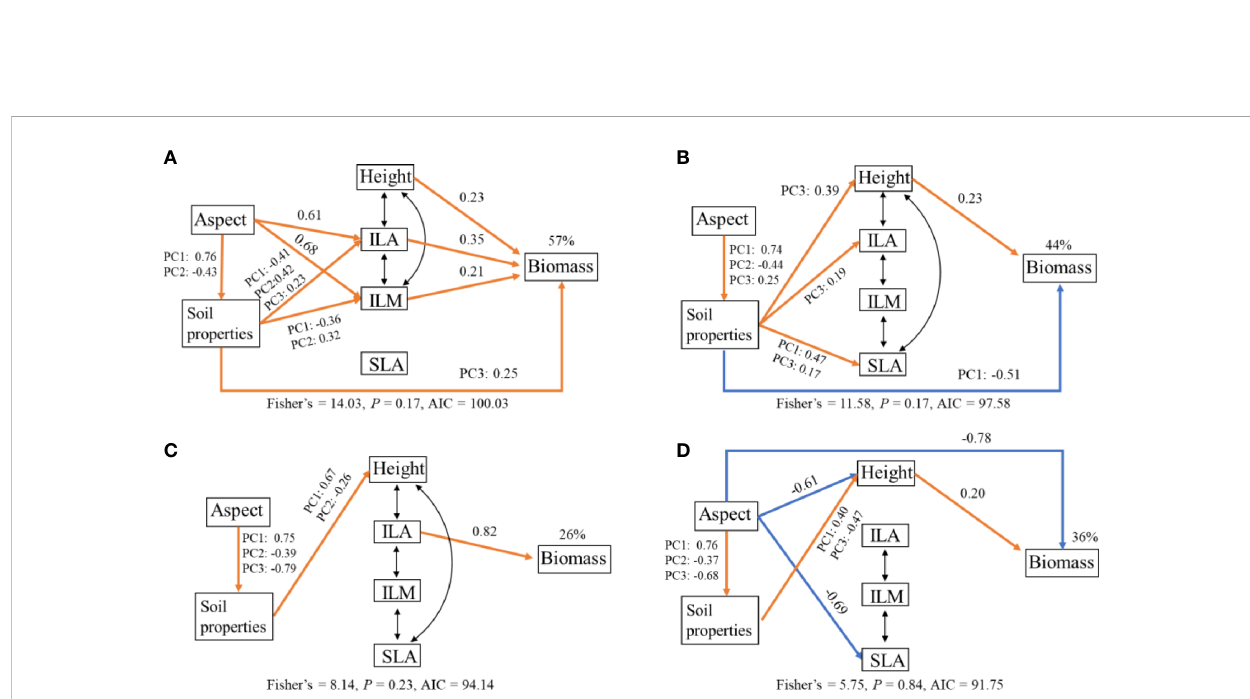
FIGURE 6 Structural equation model relating total biomass of Bistorta macrophylla (A) , Bistorta vivipara (B) , Cremanthodium discoideum (C) , and Deschampsia littoralis (D) to slope aspect (Aspect), soil properties, height (Height), individual leaf area (ILA), individual leaf mass (ILM), and speci fi c leaf area (SLA) in alpine grassland. The coef fi cients are standardized prediction coef fi cients for each causal path. Orange and blue lines represent signi fi cant positive and negative associations, respectively, and black bi-directional arrows indicate correlations. PC1, PC2, and PC3 indicate the fi rst three PCA axis of soil properties. The percentages above Biomass indicate the proportion of variance